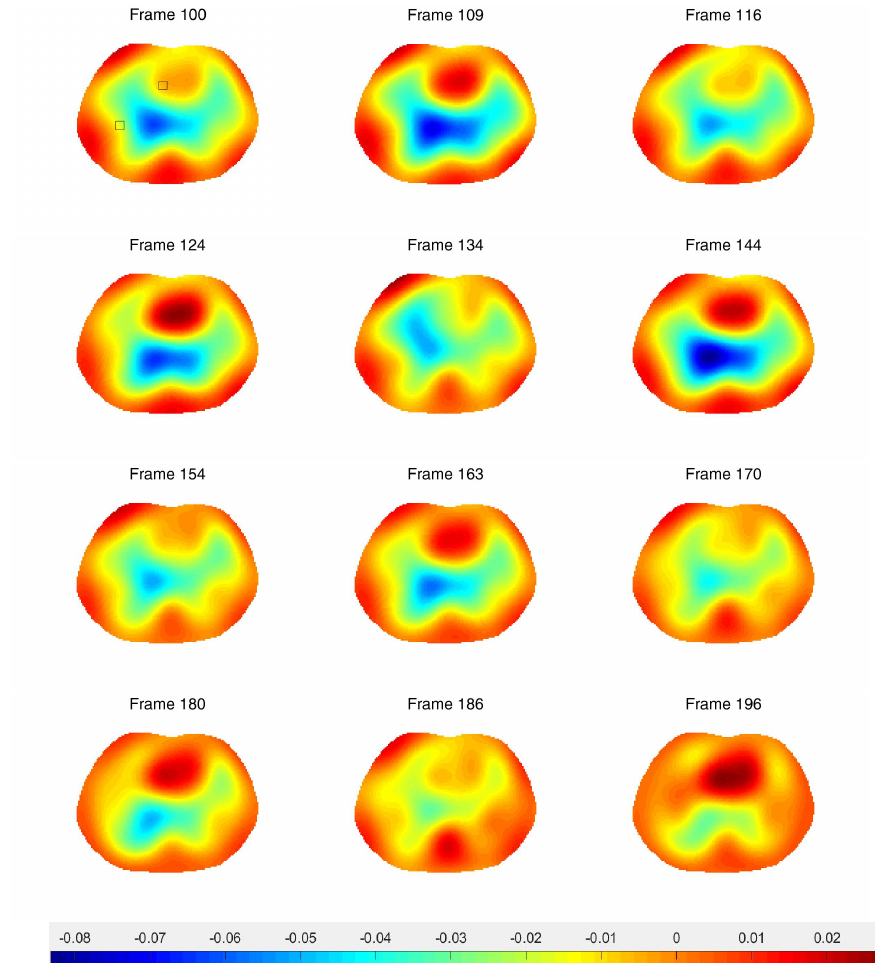
Figure 12. Difference images of breath holding data with the spatial prior included in the algorithm. Averaged voltage data were used for the reference data. The inner truncation radius is 1.2 and the outer truncation radius is 3. The small squares superimposed on the upper left figure indicate the pixels chosen for the time traces in Figure